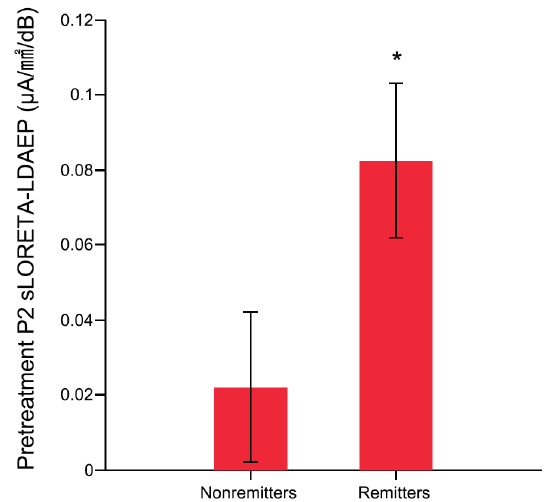
Figure 2. The pretreatment left P2 standardized low resolution brain electromagnetic tomography (sLORETA)-LDAEP of remitters and nonremitters (remitters were defined as those with <10 points in the post-treatment BDI score) among MDD patients ( t = − 2.095, p = 0.043). The data are presented as mean and standard error values. * Statistically significant difference at p < 0.05.